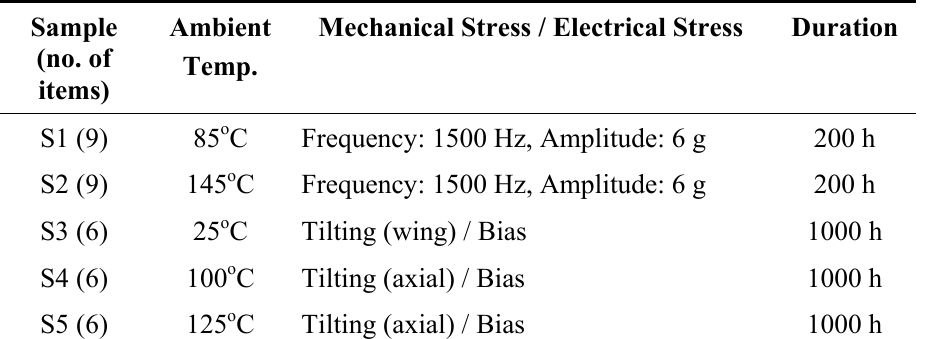
Table 2. Test plan.